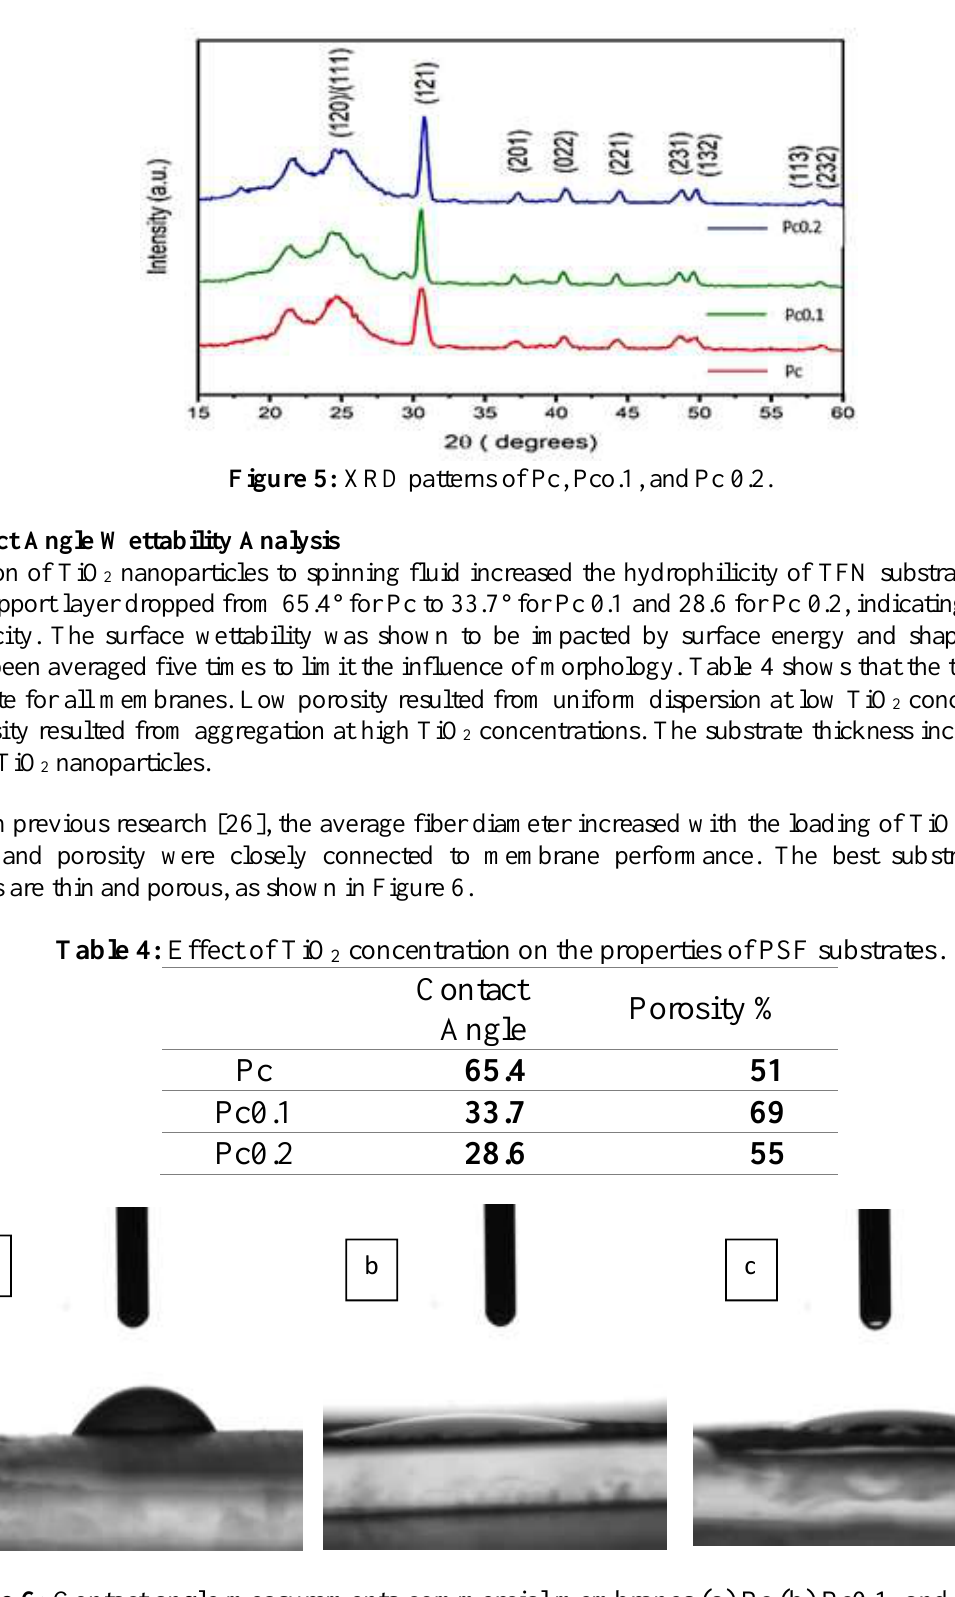
Figure 6: Contact angle measurements commercial membranes (a) Pc (b) Pc0.1, and (c) Pco.2.